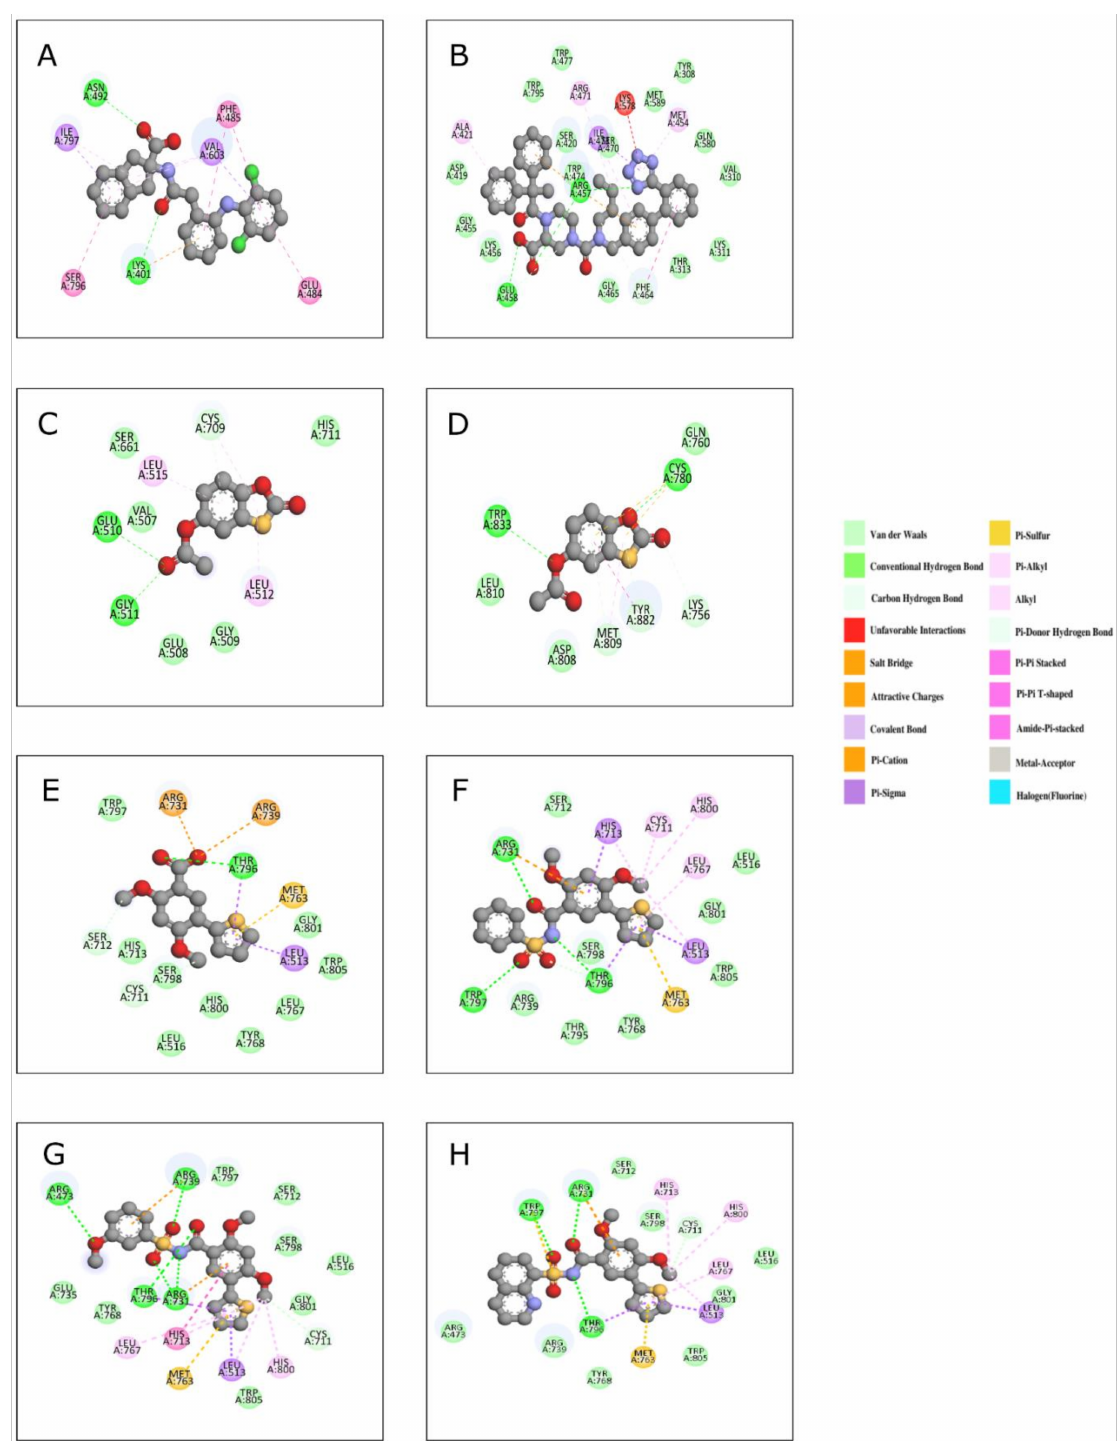
Figure 12. The DENV and Zika RdRP inhibitor complexes showing the interactions of different residues with the bound inhibitor: ( A ) DENV3 RdRP–NITD-434 (PDB 6XD0), ( B ) DENV3 RdRP– NITD-640 (PDB 6XD1), ( C ) DENV2 RdRP–RK0404678 (PDB 6IZX), ( D ) DENV2 RdRP–RK0404678 (PDB 6IZZ), ( E ) Zika virus RdRP–compound 7 (PDB 6LD2), ( F ) Zika virus RdRP–compound 13 (PDB 6LD3), ( G ) Zika virus RdRP–compound 14 (PDB 6LD4), ( H ) Zika virus RdRP–compound 15 (PDB